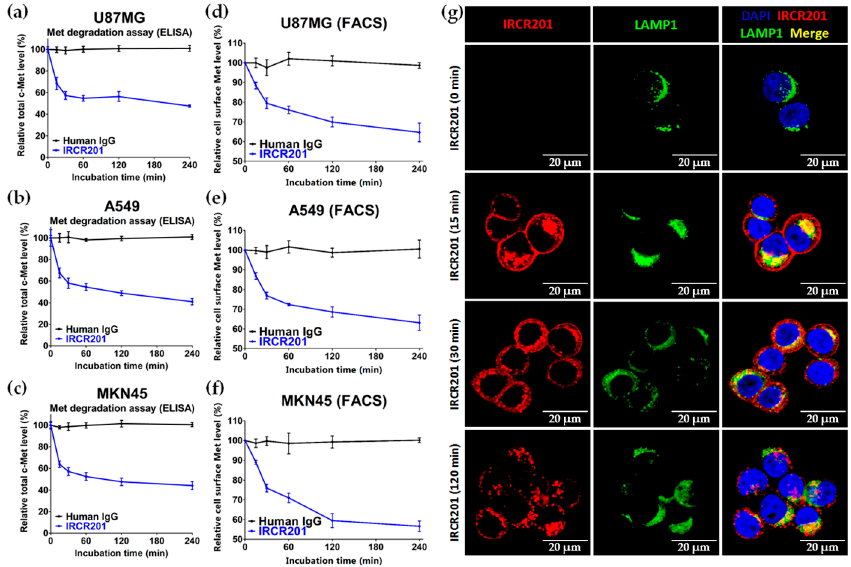
Figure 6. Effect of IRCR201 on c-Met receptor internalization and degradation. ( a – c ) U87MG, A549, and MKN45 were treated with 100 nM IRCR201 or human IgG for the indicated durations and lysed. The level of total c-Met was measured by ELISA-based assay as described in the “Materials and Methods” section; ( d – f ) After c-Met-positive cell lines were incubated with 100 nM of IRCR201 or human IgG for 30 min at 4 °C, the cell lines were incubated at 37 °C to induce internalization and degradation of the c-Met/IRCR201 complex. The residual levels of cell surface c-Met were detected by rabbit anti-c-Met antibody-conjugated Alexa Fluor ® 488 in which the epitope of IRCR201 does not overlap. The c-Met levels on the cell surface were measured based on the mean fluorescence intensity (MFI) and normalized to a value of MFI at 0 min; ( g ) MKN45 cells were treated with 100 nM IRCR201 at 37 °C. Thereafter, IRCR201 was allowed to internalize for up to 120 min at 37 °C. MKN45 cells were then stained with anti-human IgG-Alexa Fluor ® 647 to recognize IRCR201 and anti-LAMP1-Alexa Fluor ® 488 to detect lysosomes. The fluorescence images are visualized by confocal microscopy.